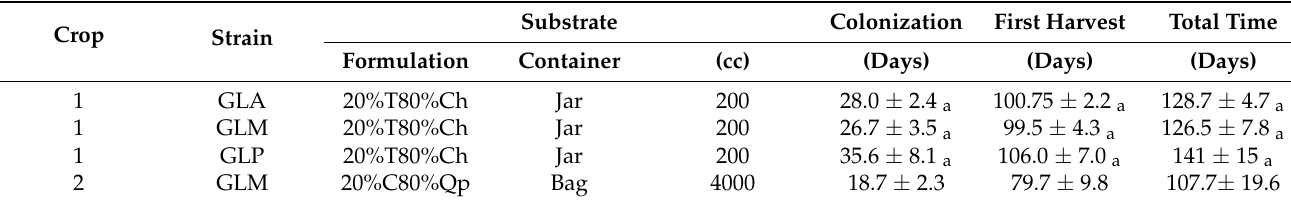
Table 1. Summary of cultivation of different Iberian strains of Ganoderma lucidum (GL). GLA: GL from Aveiro, Portugal. GLM: GL from Madrid, Spain. GLP: GL from Palencia, Spain. T: wheat grain. Ch: poplar chips. C: whole rye grain. Qp: Pyrenean oak chips.